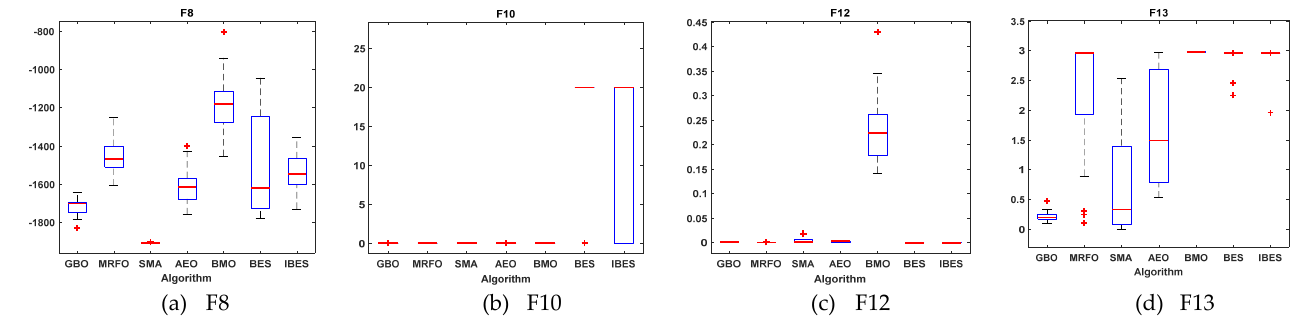
Figure 11. Boxplots for all algorithms for multimodal benchmark functions ( a ) F8, ( b ) F10, ( c ) F12, and ( d ) F13.